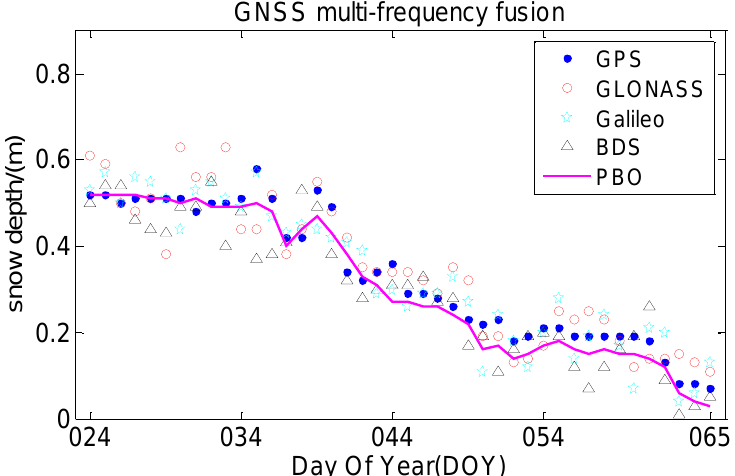
Figure 12. Mean fusion of multi-frequency retrieval results in the four GNSS systems.